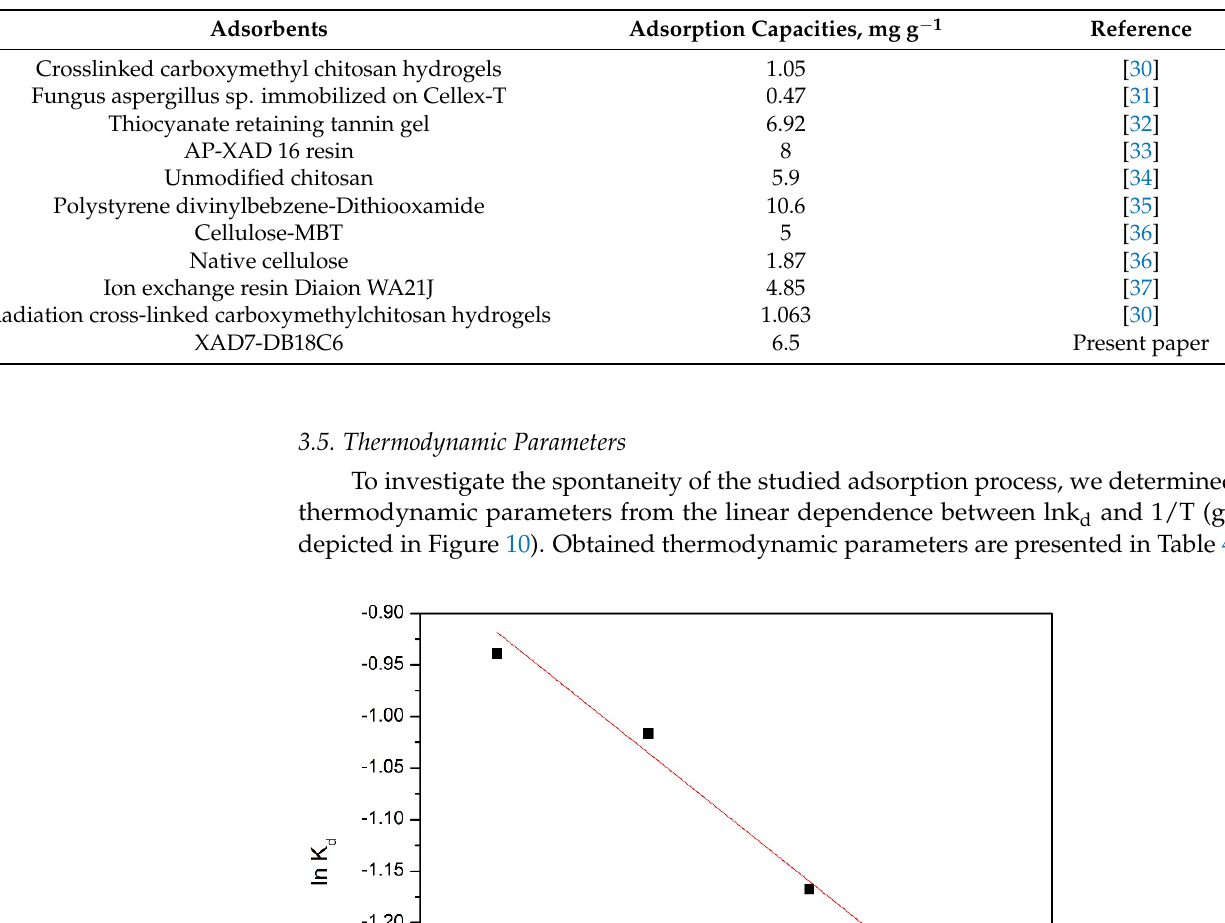
Table 3. Comparison to other materials for Pd(II) adsorption.